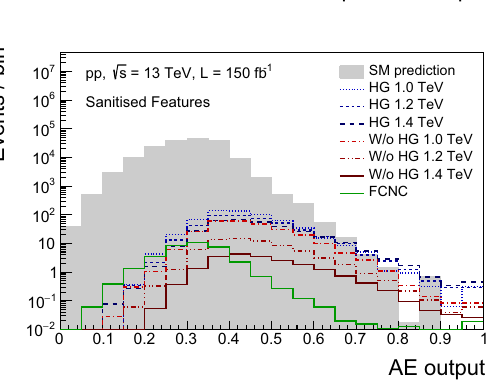
tributions are normalised to the generation cross-section and to an inte- grated luminosity of 150 fb − 1 . Left: Using all features set. Right: Using sanitised features